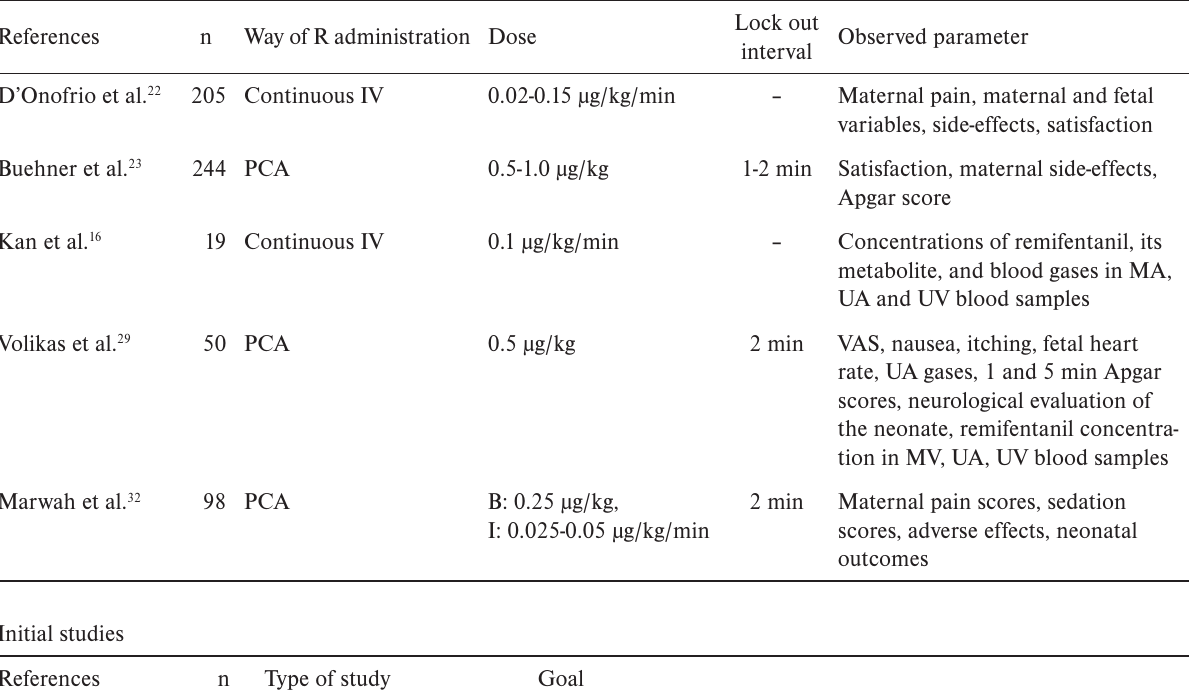
Table 4. Observational studies of remifentanil intravenous analgesia and initial studies of remifentanil in labour. Observational